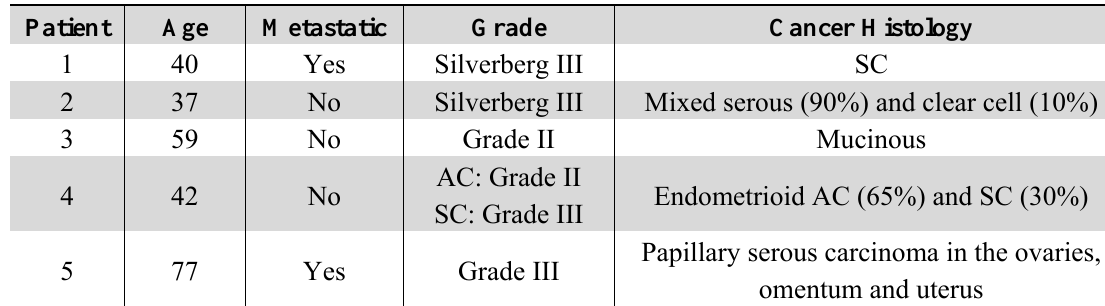
Table 1. Patient